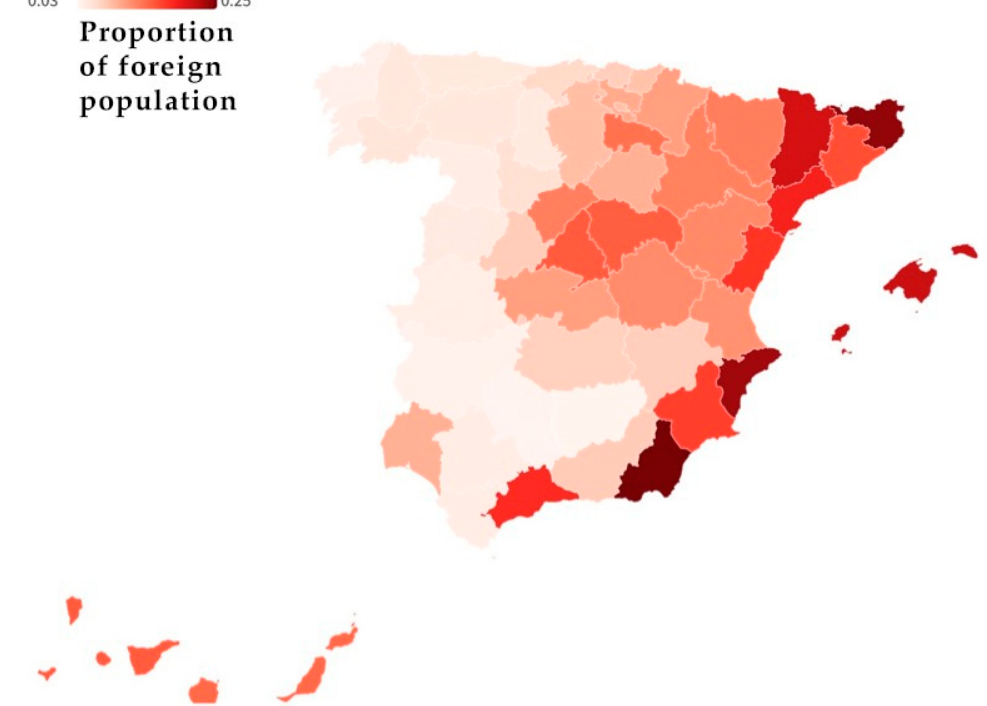
Figure 1. Average proportion of foreign population in Spain (2015–2020). Own elaboration, based on data from the Instituto Nacional de Estad í stica INE (2022).